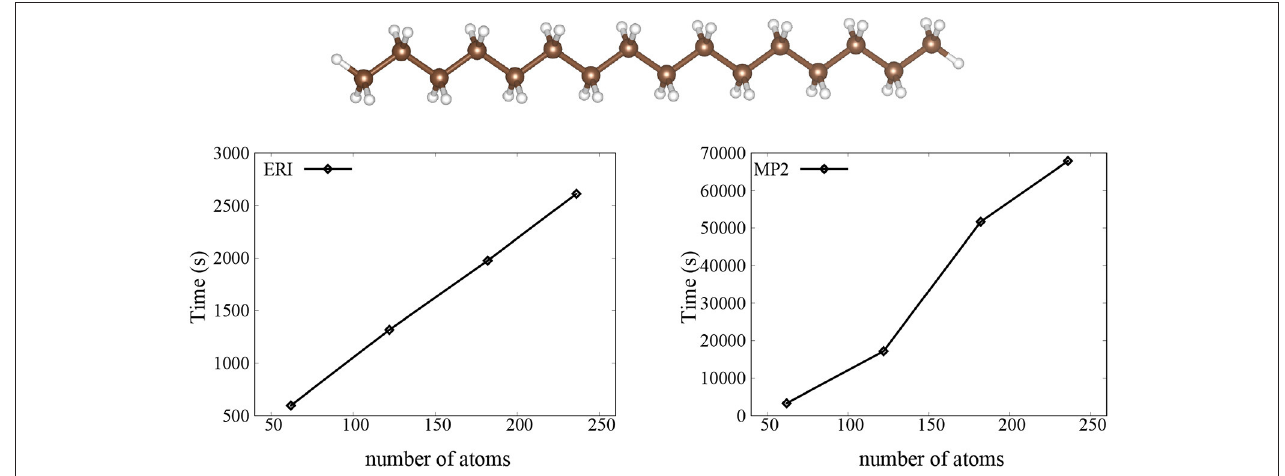
FIGURE 1 | The CPU time for the ERI and MP2 calculation using SZ basis set. Here, the trans-polyacetylene molecules are used as the test systems.